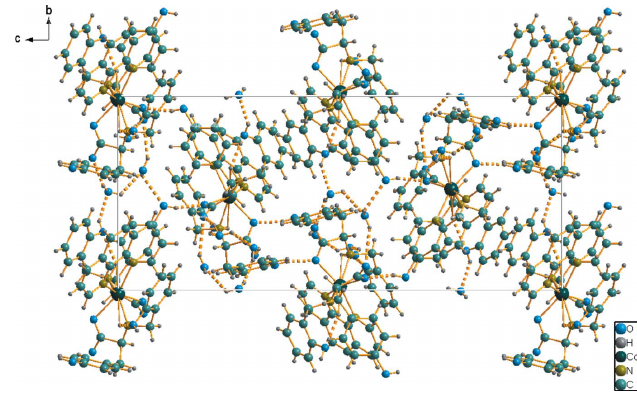
Figure 2 The crystal packing of the title compound viewed along the a axis. Hydrogen bonds are shown as dashed lines (see Table 1 for details).